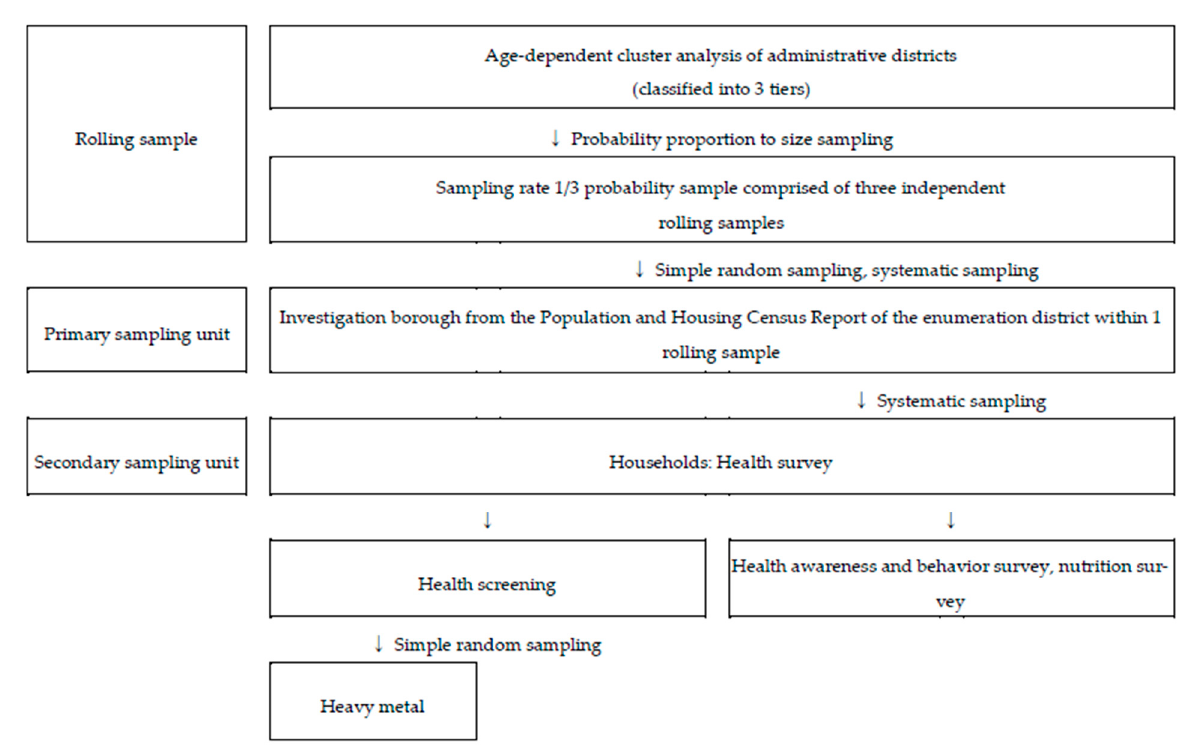
Figure 1. Korea National Health and Nutrition Examination Survey sampling design flow chart.